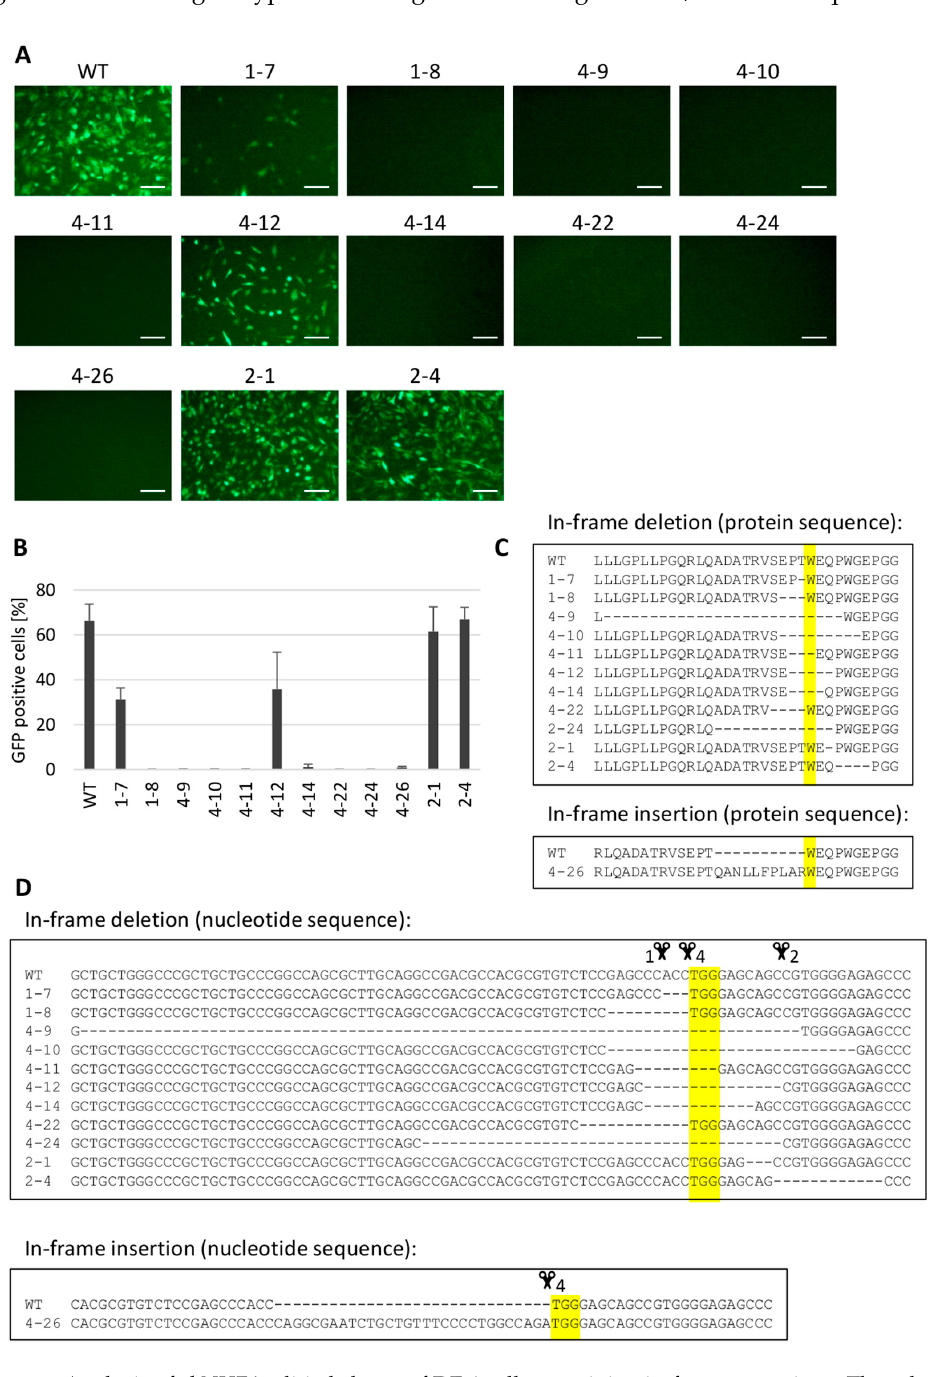
Figure 5. Analysis of chNHE1 -editied clones of DF-1 cells containing in-frame mutations. The selected clones were challenged with the RCASBP(J)GFP reporter virus. The virus spread in the cell culture was assayed as the presence of GFP-positive cells by fluorescence microscopy ( A ) or FACS ( B ). Predicted amino-acid sequence of chNHE1 (position 15-47) in selected clones is depicted ( C ). The in-frame deletions and one in-frame insertion homozygous in both chNHE1 alleles of these clones are shown ( D ) with the cleavage points represented by the scissors. The critical W38 and the corresponding TGG trinucleotide are highlighted in yellow. The FACS experiment was done in two parallels in two independent experiments and the results are shown as the mean ± standard errors. Scale bar = 100 μ m.